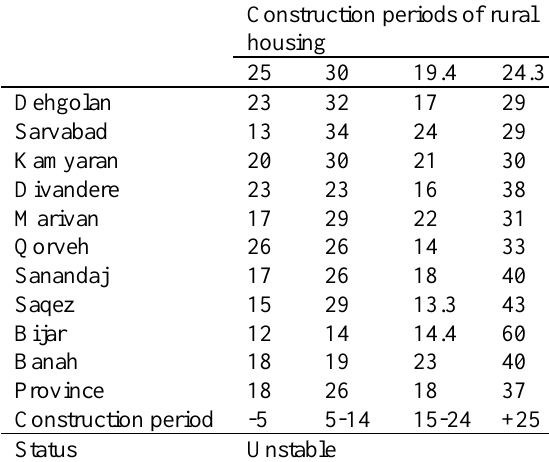
Table 3. Periods of rural housing construction